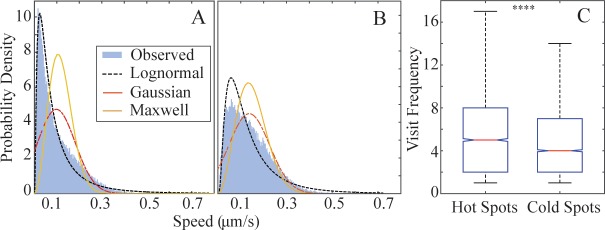
T cells visiting hotspots show a different distribution of speeds than T cells that do not visit hotspots.Cold tracks (A) have a speed distribution that is more peaked at low speeds with a more skewed, heavy-tailed distribution compared to hot tracks (B). For fits, see Table 6. (C) Visit frequency, or number of observations of hot tracks in hot vs. cold spots. Hot tracks were observed to visit hotspots more than cold spots. The graph shows the distribution of average number of visits by hot tracks to hotspots versus cold spots. Interquartile box plot of the distribution with the red line indicating the median number of visits. Outliers are not shown. **** indicates p<<10−3 using Mann-Whitney U test.